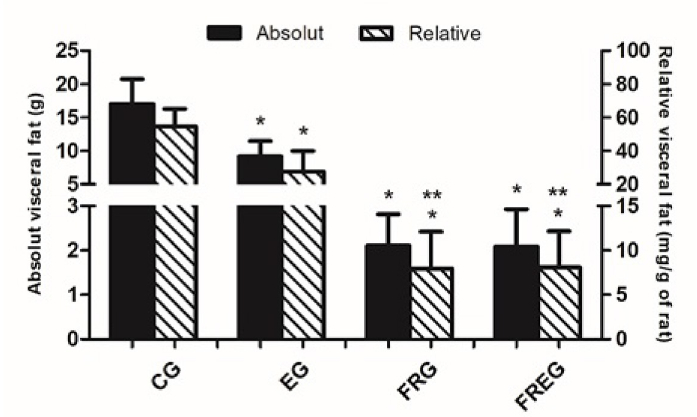
Figure 2 - Data from relative and absolut visceral fat in control (CG), exercised (EG), food restriction (FRG), and food restriction/exercised (FREG) from female rats. Values expressed as mean and standard deviation. *p<0.05 in relation to CG and **p<0.05 in relation to EG. g: grams; mg: milligrams. All comparison among groups at the same moment. The lower ES for the absolut visceral fat (EG in relation to CG) = 2.61. Lower ES for the relative visceral fat (FREG in relation to EG) =